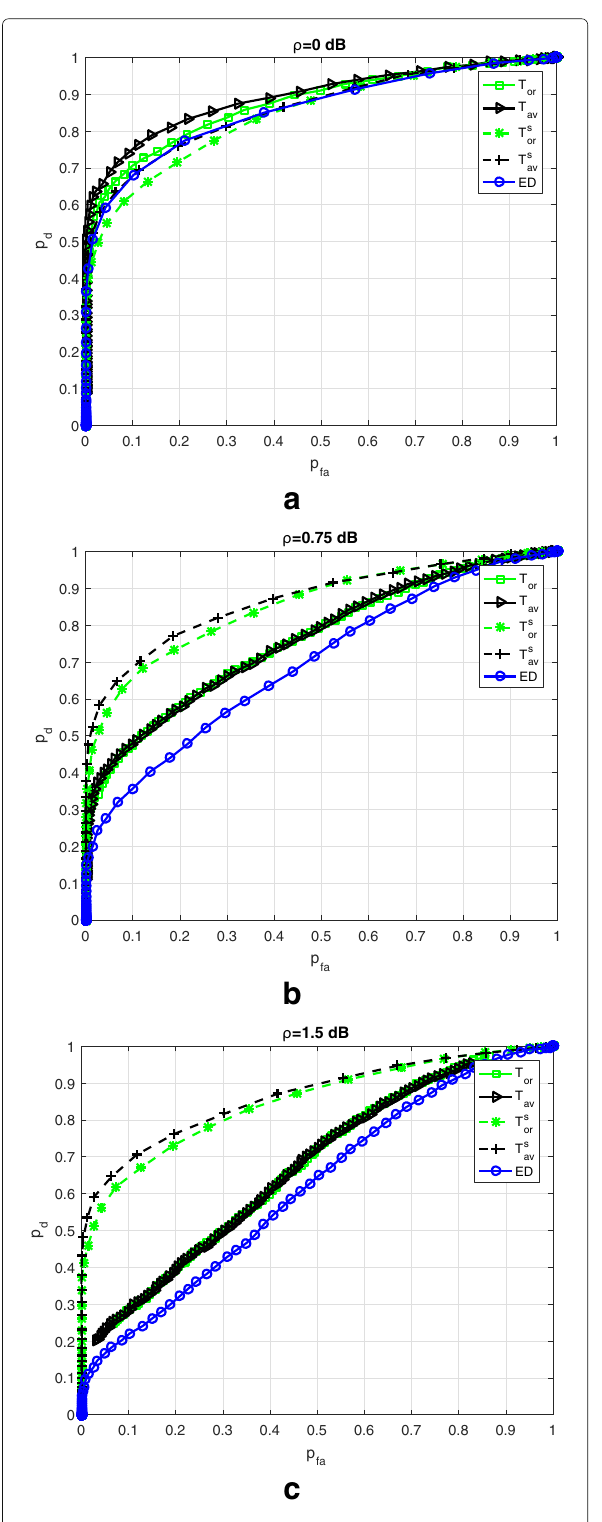
Fig. 13 ROC curves of the proposed schemes under Rayleigh channel and various values of NU, N =1000 samples and SNR = -10 dB. a ρ = 0 dB. b ρ = 0.75 dB. c ρ = 1.5